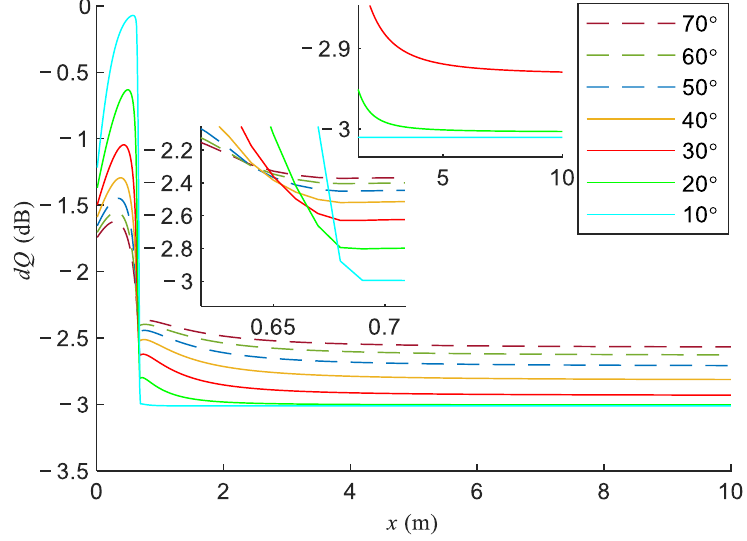
Figure 8. Differences in the Q between Figure 7 and Figure